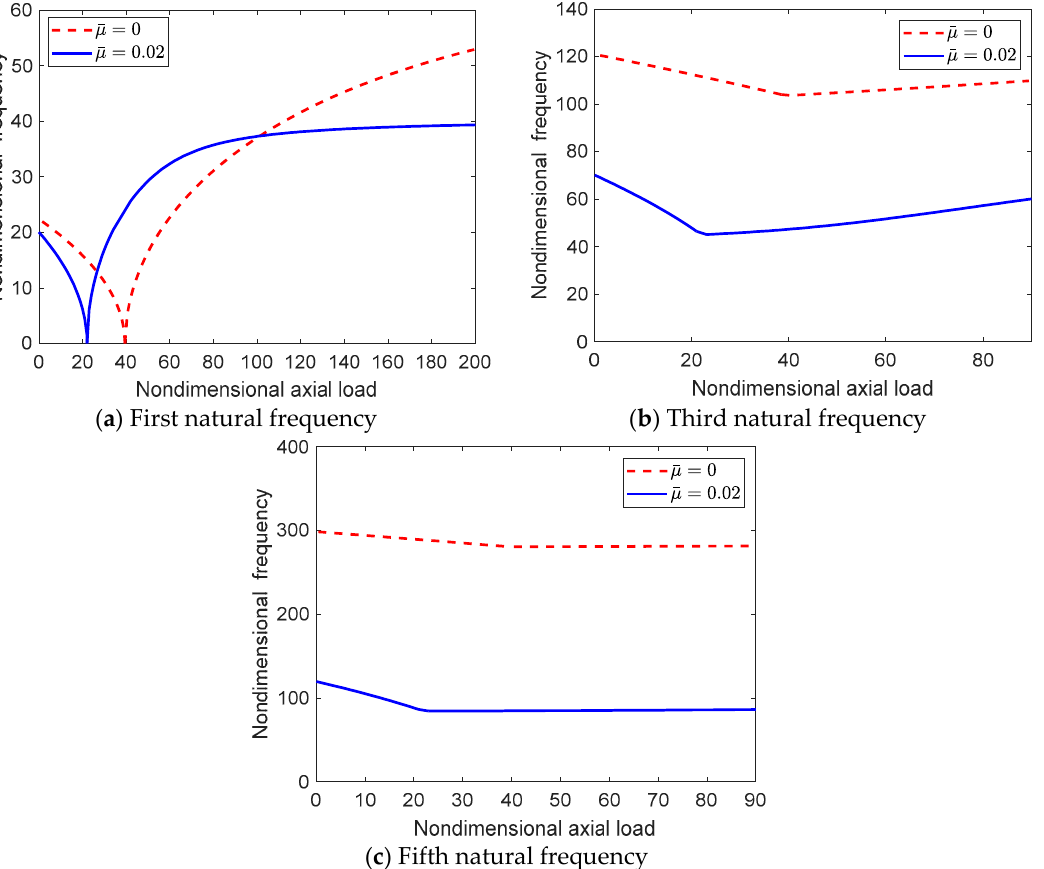
Figure 10. The variation of the first, third, and fifth natural frequencies with the applied axial load for 𝛼 = 1 of the perfect nanobeam, 𝑎 = 0 , and 𝜇̅ = (0,0.02) .